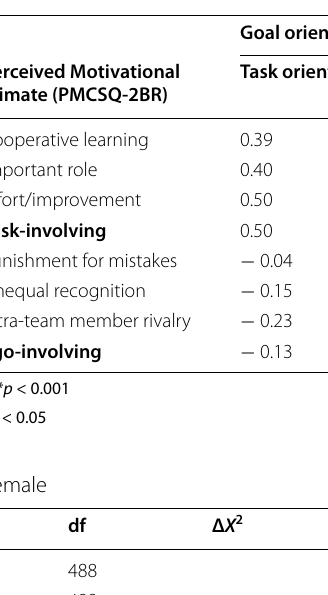
Table 7 Correlations between the six scales of PMCSQ-2BR and two scales of